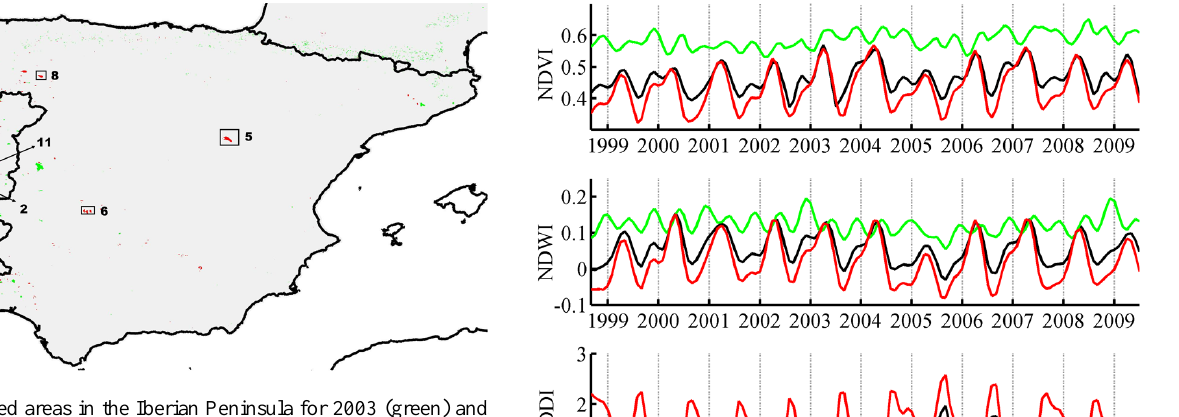
Fig. 1. Burned areas in the Iberian Peninsula for 2003 (green) and for 2005 (blue) fire seasons. Selected areas and respective nomen- clature are indicated by rectangular boxes and numbers for 2003 (green areas 1 to 4) and for 2005 (red areas 5 to 12).